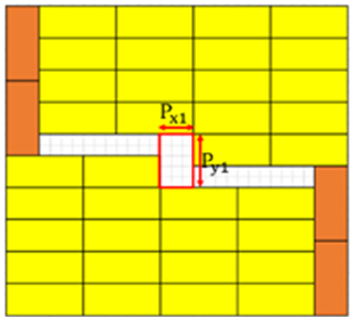
Figure 13. The area after calculation when Block 1 and Block 3 are overlapped.